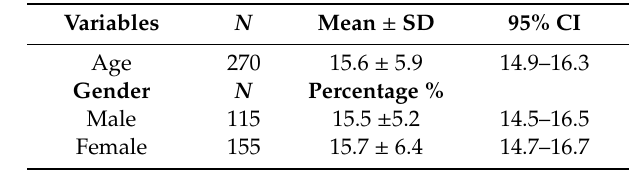
Table 1. Age and gender